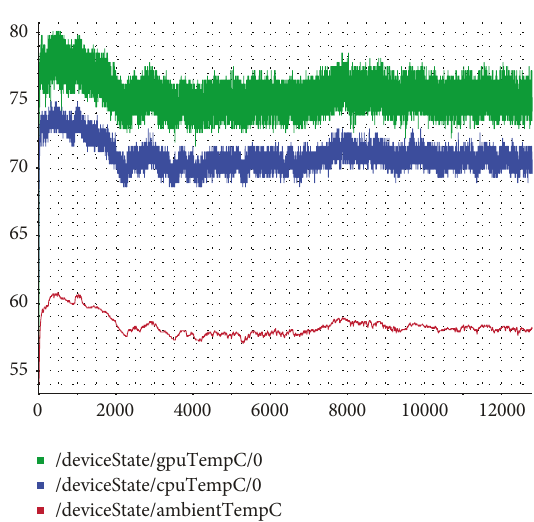
Figure 56: T2N1 temperatures.